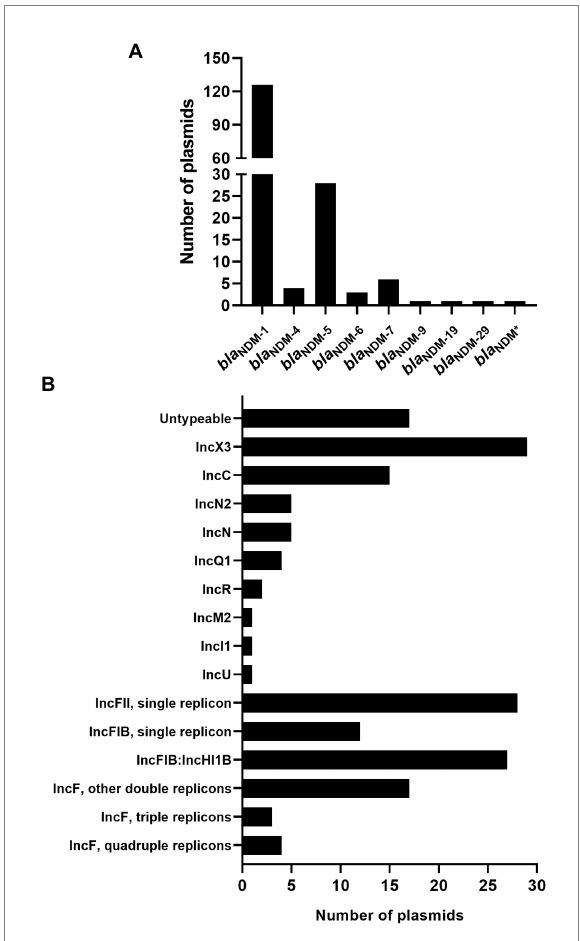
FIGURE 1 Characteristics of the 171 bla NDM -harboring plasmids of Klebsiella pneumoniae . (A) Histogram of number of variants of bla NDM genes among the 171 bla NDM -harboring plasmids of K. pneumoniae . bla NDM* representing an unknown variant of bla NDM . (B) An overview of the plasmid replicon types among the 171 bla NDM - harboring plasmids of K. pneumoniae analyzed using software